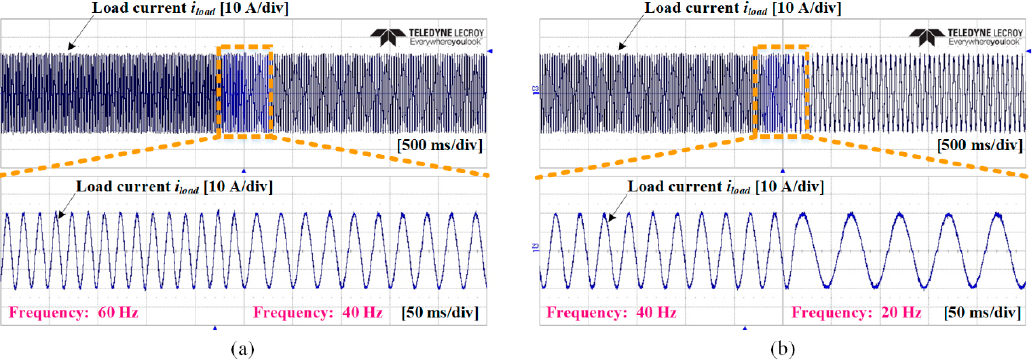
Figure 11. Experimental results for the frequency control. ( a ) Frequency: 60 Hz → 40 Hz; ( b ) Frequency: 40 Hz → 20 Hz.